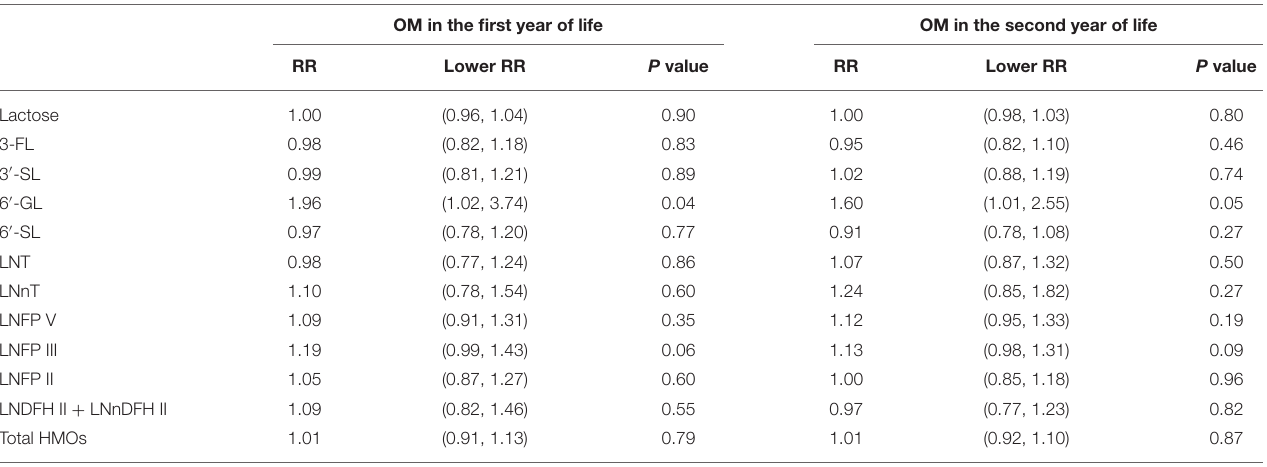
TABLE 8 | Adjusted associations between human milk oligosaccharides in group II milk measured at 6 weeks of lactation with otitis media in the first or second year of life in the Ulm SPATZ Health Study. OM in the first year of life OM in the second year of life RR Lower RR P value RR Lower RR P value